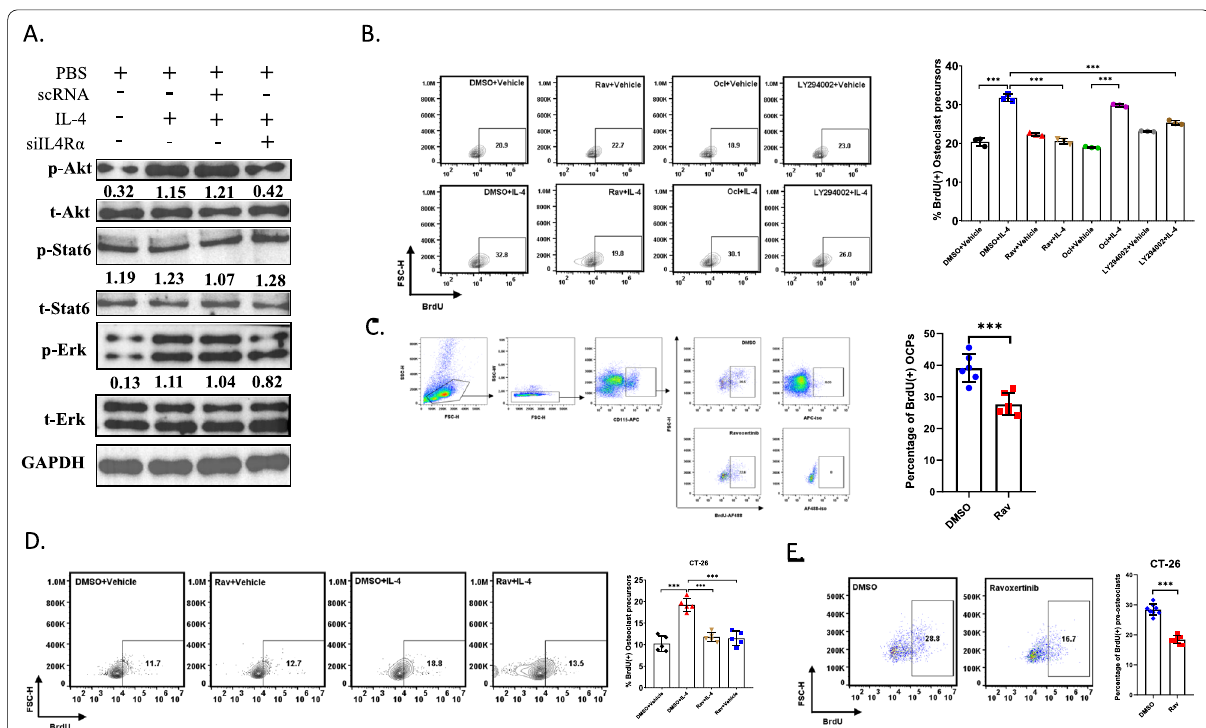
Fig. 4 ERK pathway regulating IL4/IL4Rα‑mediated proliferation of early OCPs. A Western blotting showed the protein level of ERK pathway, JAK‑STAT pathway and PI3K‑AKT pathway. (n 3) B Flow cytometry plots and quantification of BrdU( ) early OCPs after treated by recombinant = + IL‑4 protein with/without each antagonist of ERK pathway, JAK‑STAT pathway and PI3K‑AKT pathway, respectively.